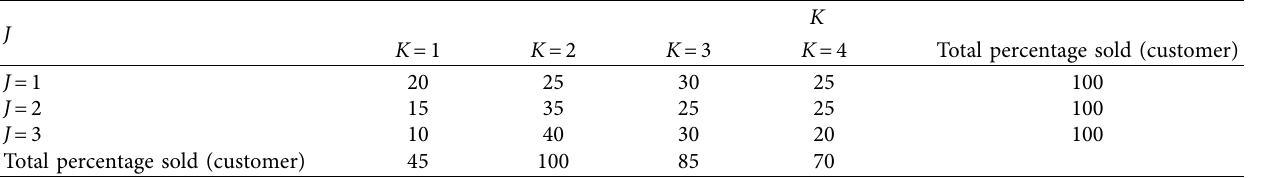
Table 2: Optimal value of β